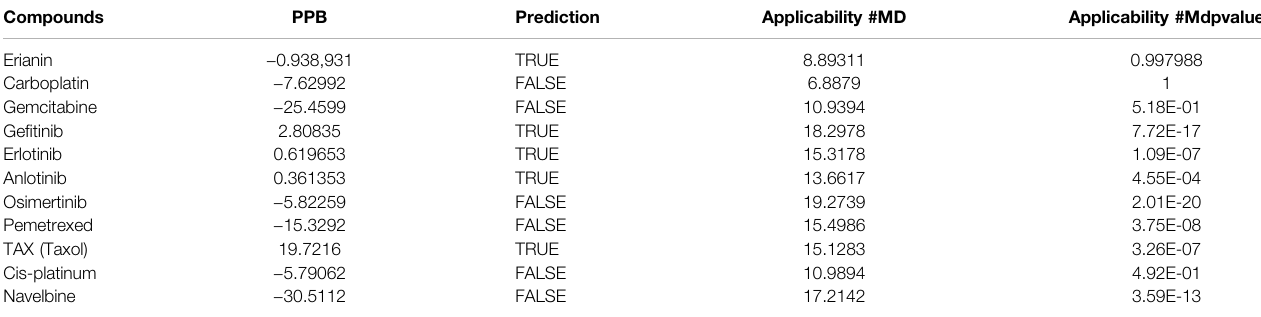
TABLE 5 | Plasma protein binding (PPB) rate prediction of erianin and reference drugs. Compounds PPB